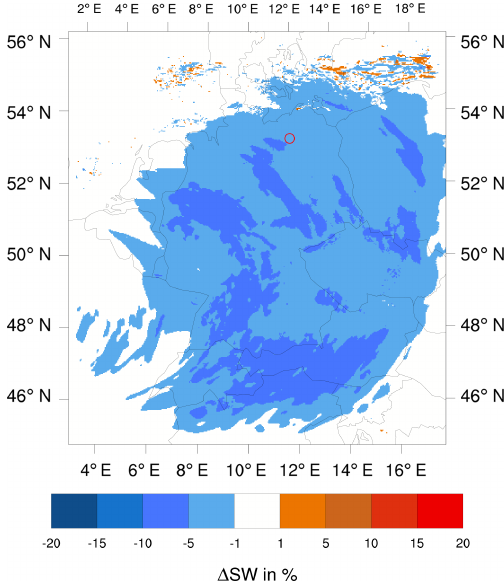
Figure 12. Average changes in the amount of incoming diffuse and direct solar radiation during daylight hours of 3 December 2013 at the surface (aviation simulation minus reference simulation). The red circle (53 ◦ N, 12 ◦ E) marks the location evaluated in Fig.